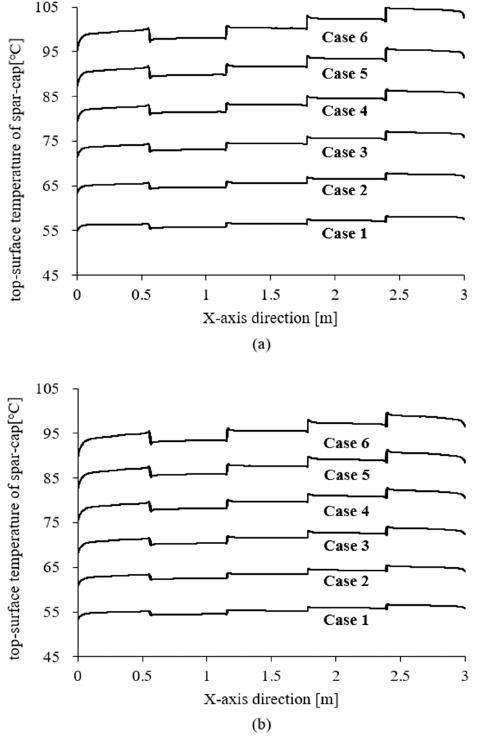
Figure 6. Top-surface temperature of spar-cap with steady state analysis (reference models): ( a ) alu- minum mold; ( b ) GFRP mold.